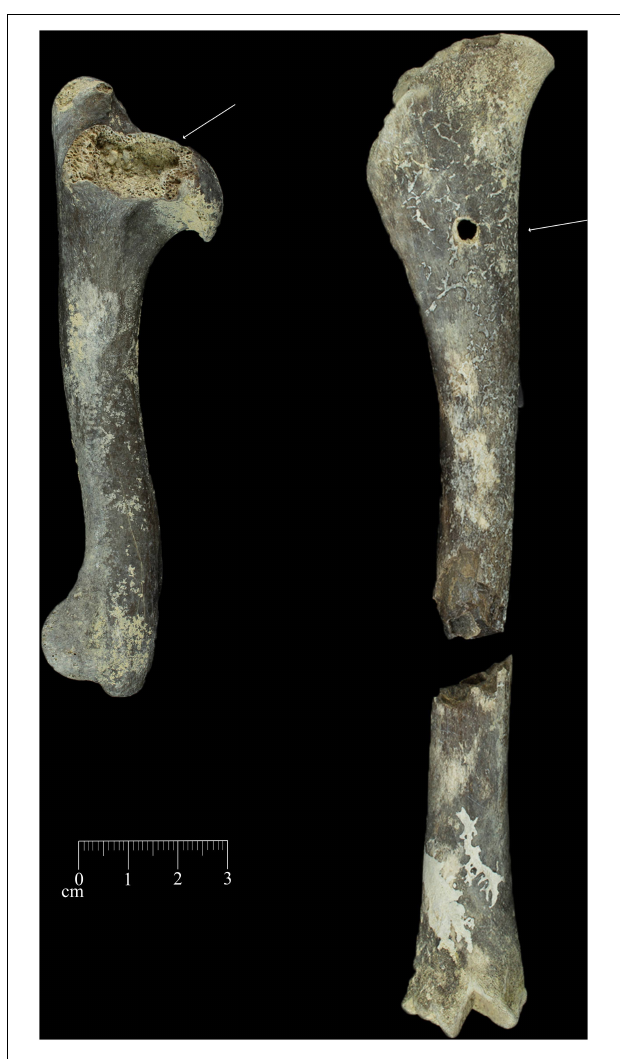
FIGURE 7 | Example of carnivore modifications; tooth marks present at Ewass Oldupa. Carnivore modifications present on specimens. (Right) Arrow denoting furrowing present on humeral proximal end. (Left) Arrow indicating puncture mark present on proximal shaft of tibia.